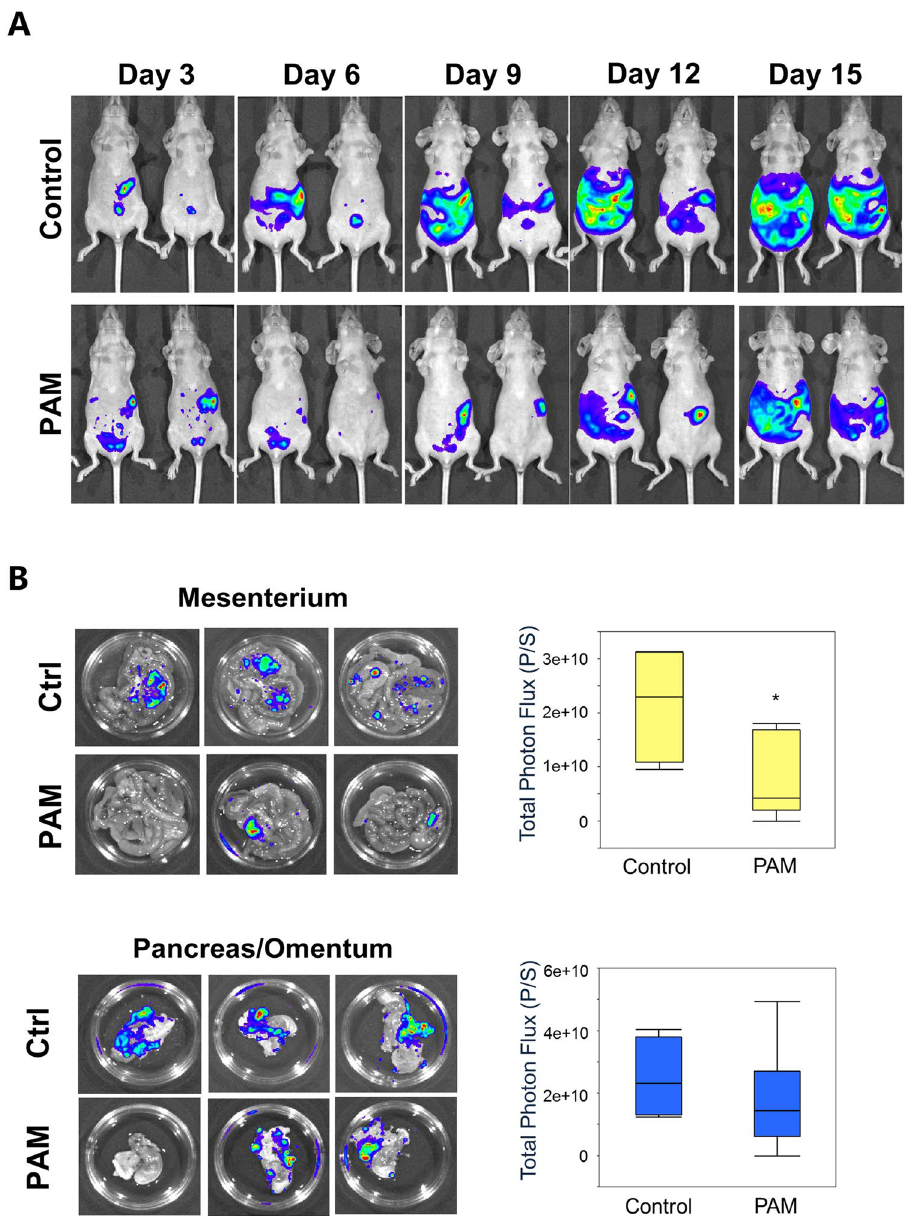
Figure 8. Plasma-activated medium (PAM) suppresses intraperitoneal metastasis in an ovarian cancer mouse model. ( A ) Peritoneal metastases between the PAM and control groups are indicated with bioluminescence using the IVIS system every 3 days, until day 15. ( B ) On day 19, metastasis of ES2 cells onto peritoneal tissues (mesenterium and omentum/pancreas) is investigated and quantified with bioluminescence (photon/s) using the IVIS system. Data are presented as mean ± SD. Statistics are shown as * P <